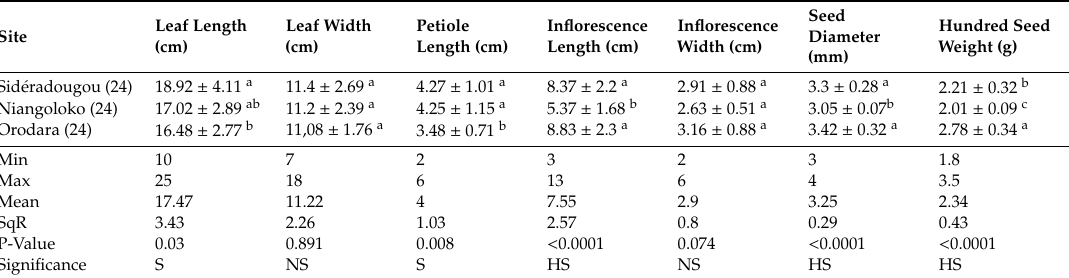
Table 5. Leaf, inflorescence, and seed parameters.